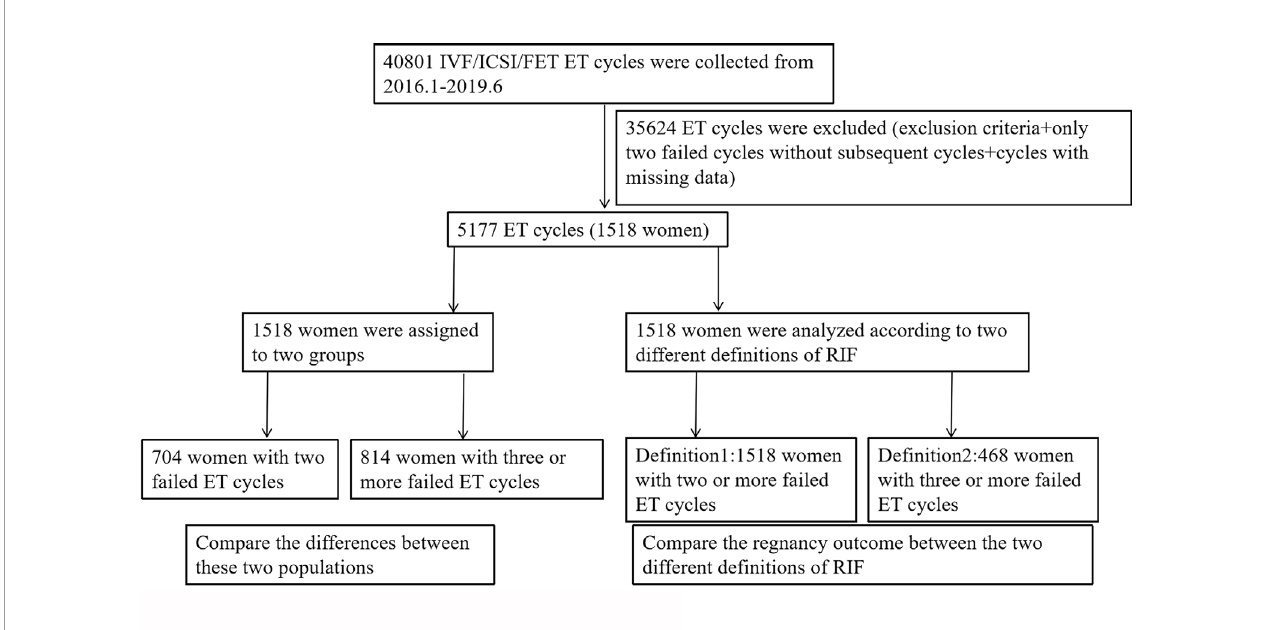
FIGURE 1 | Flow chart representing the present